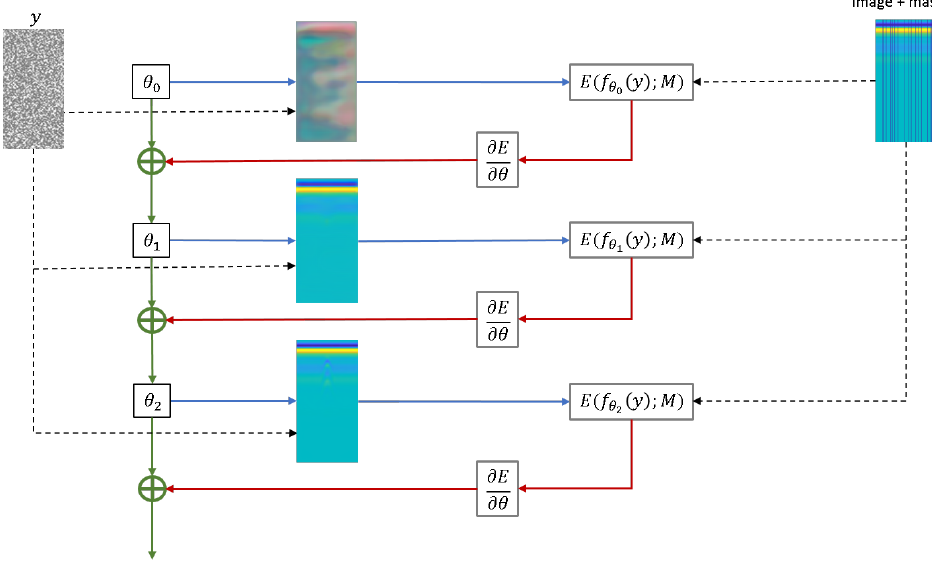
Figure 3. Block diagram of DIP